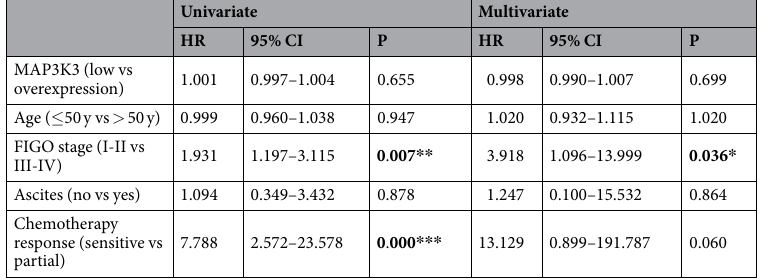
Table 3. Univariate and multivariate analyses of the associations between HGSOC Patient Risk Factors. Abbreviations: HR, hazard ratio; CI, confidence